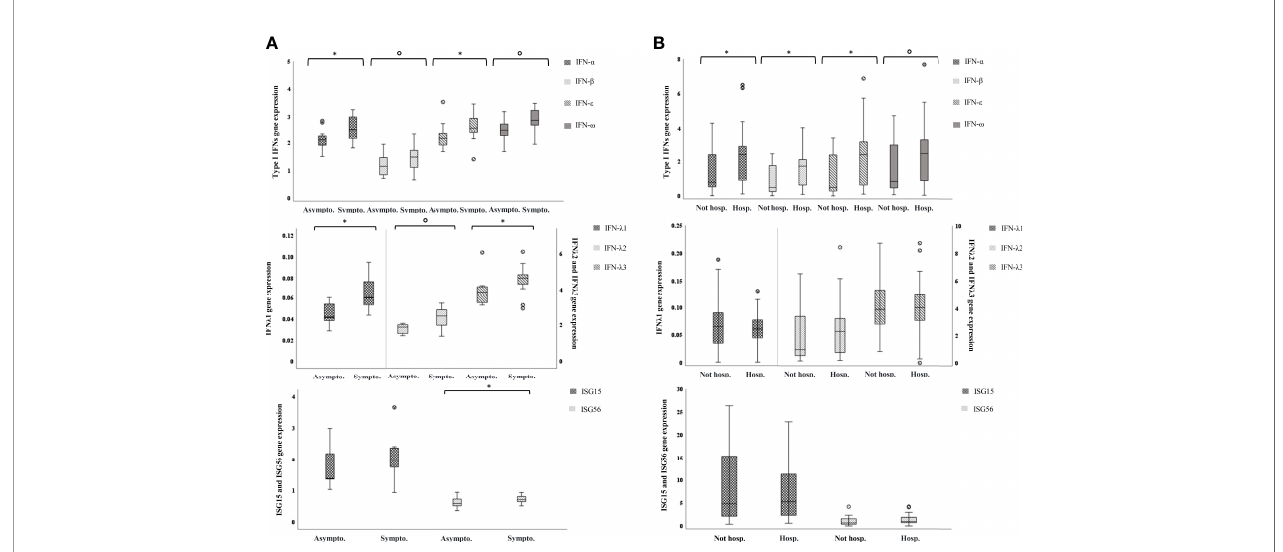
FIGURE 4 | IFN genes are more expressed in symptomatic children and in hospitalized adults. Relative mRNA expression values (y-axis), calculated using the threshold cycle relative quanti fi cation (2 - D Ct ), are shown in box plot graphs: the box represents the lower and upper quartiles, the line in the box represents the median, the whiskers show the lowest and highest values, and the outliers are represented by open circles. Above box plot pairs, p-values calculated using Mann- Whitney tests for comparisons are shown with symbols representing: °0.1<p>0.05, *0.05<p ≥ 0.001. (A) IFN genes expression in asymptomatic vs symptomatic children. (B) IFN genes expression in not-hospitalized vs hospitalized